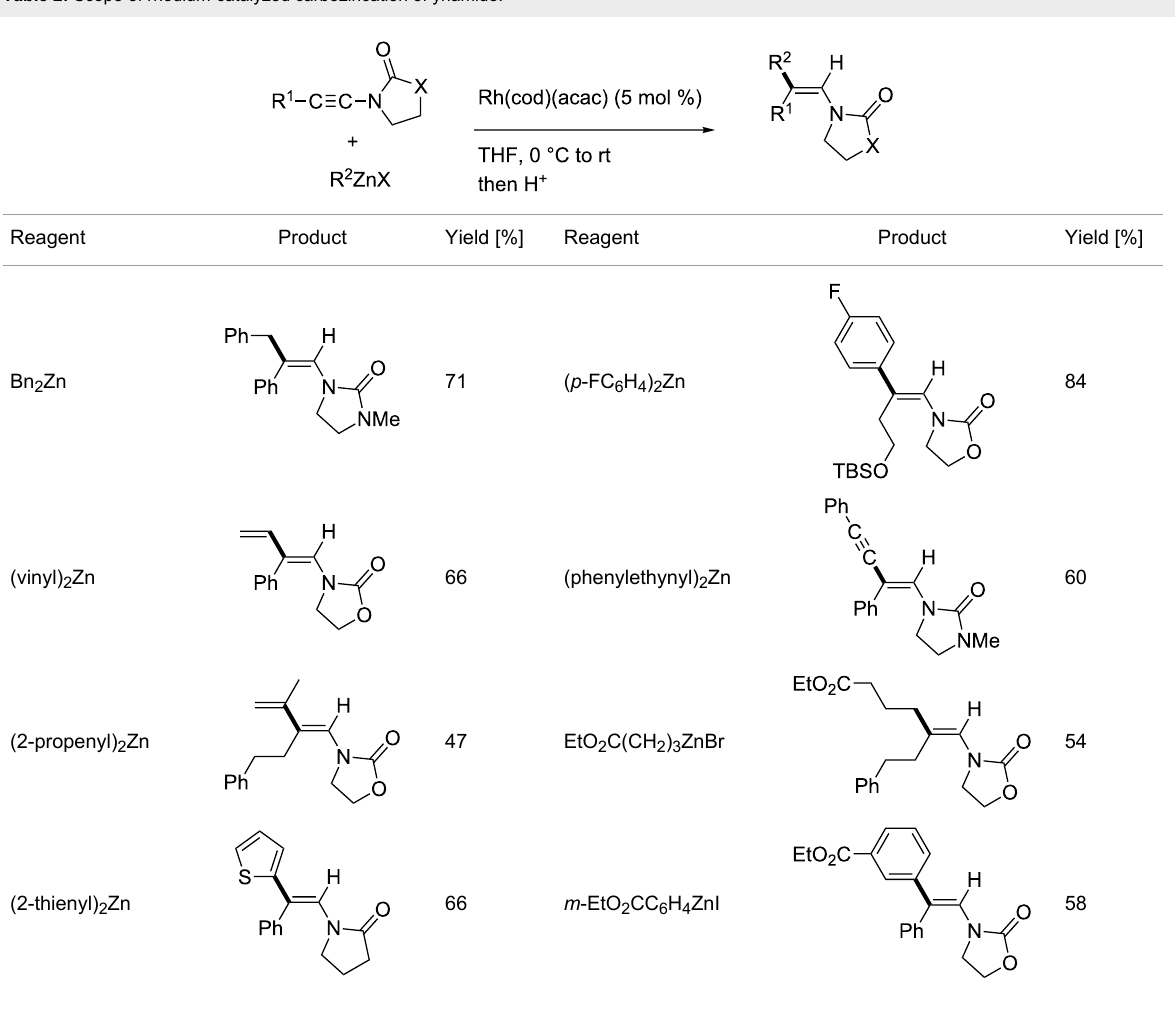
Table 2: Scope of rhodium-catalyzed carbozincation of